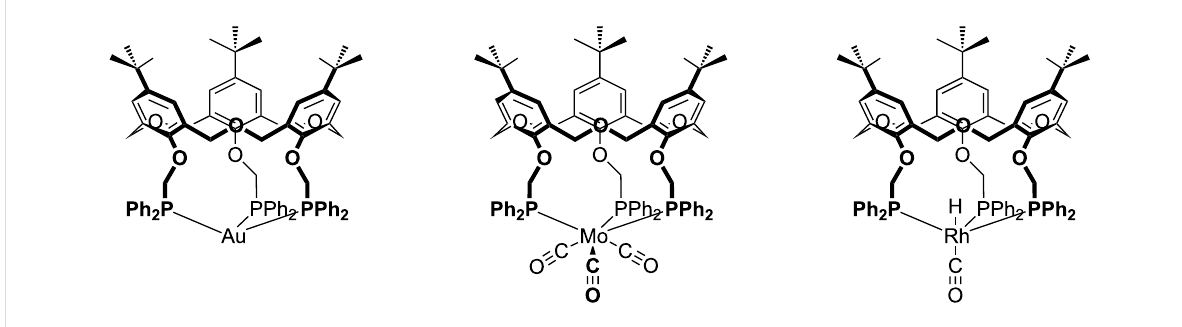
Figure 22: Phosphorylated oxacalix[3]arene complexes with transition metals: (Left to right) 26 ∙ Au, 26 ∙ Mo(CO) 3 and 26 ∙ RhH(CO) [40].